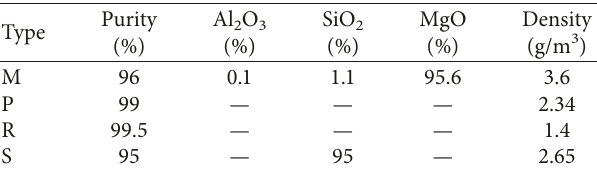
Table 1: The physical and chemical composition of the materials used in the